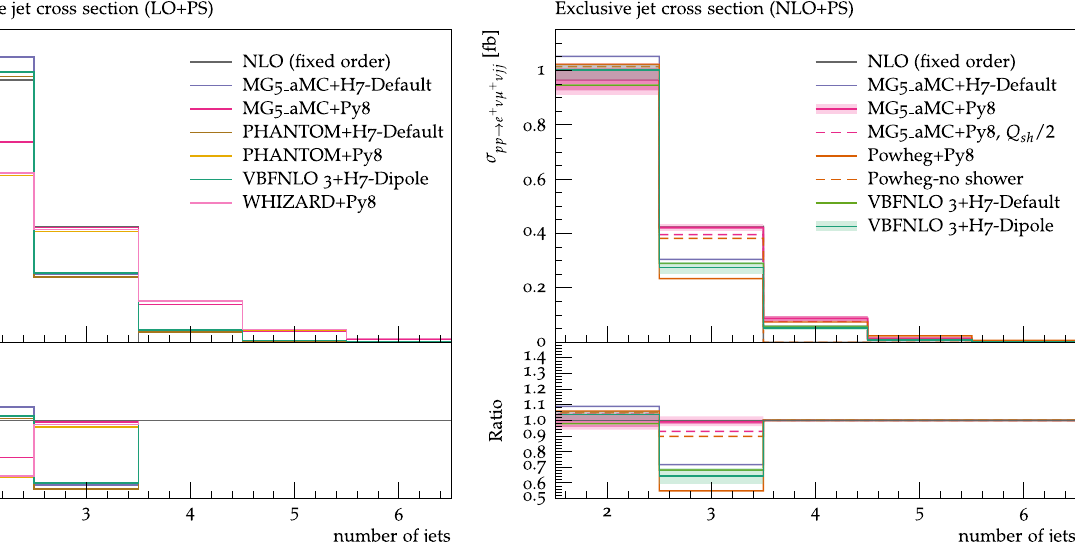
shown, while for MG5_aMC + Pythia8 the darker and lighter bands correspond respectively to the nine-point scale uncertainty and the scale and PDF uncertainties combined linearly. The predictions are obtained in the fiducial region described in Sect.